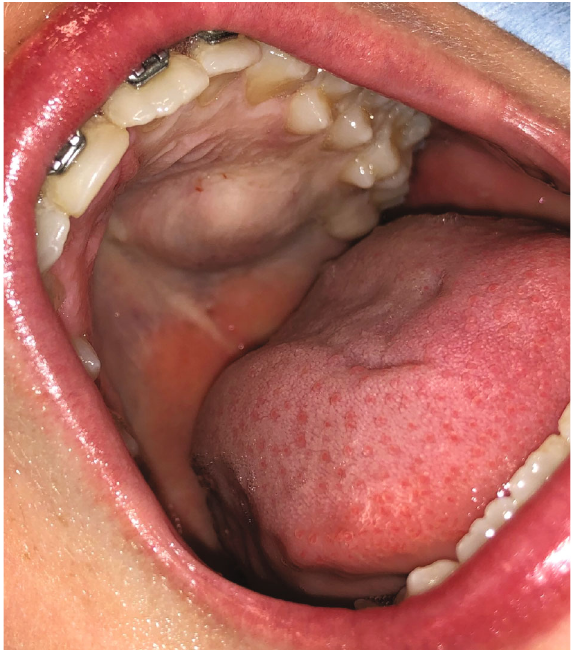
Figure 1: Photograph of the swelling of the left palate with intact overlying mucosa.